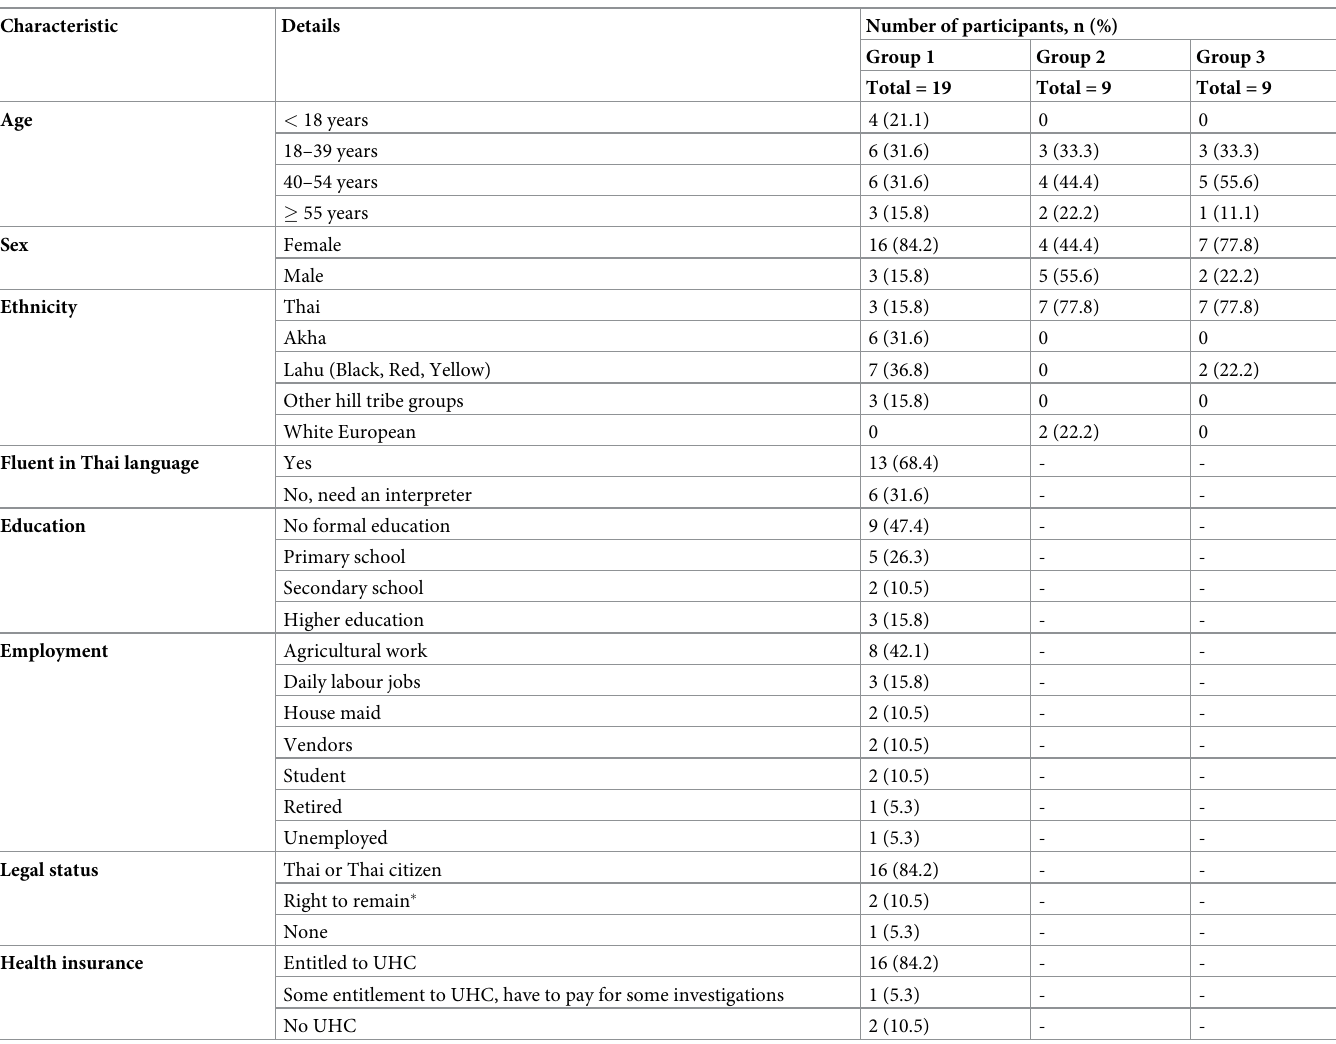
Table 3. Demographic details of the REACH research